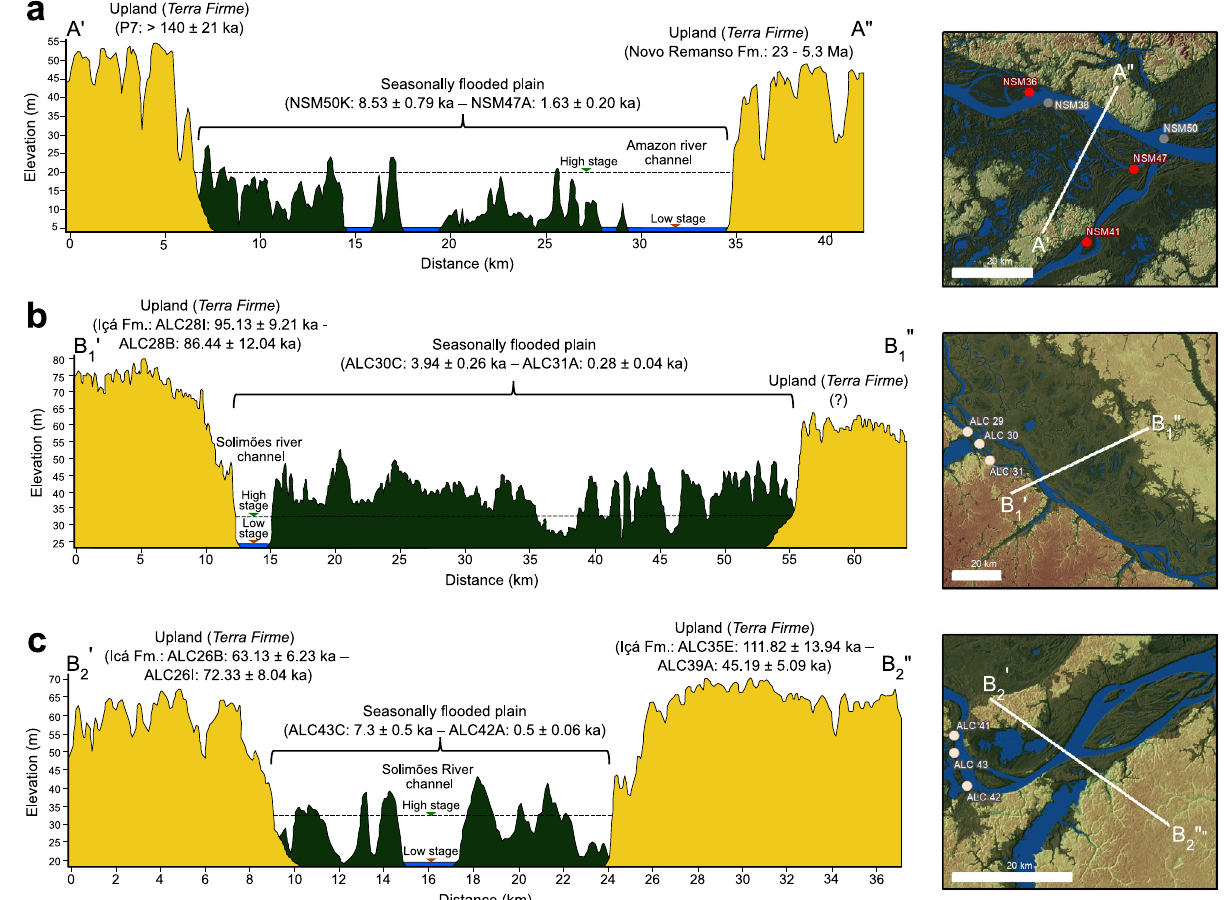
Fig. 6 | Elevation pro fi les showing the morphostratigraphic relation between upland fl uvial terraces and seasonally fl ooded plains within the Solimões- Amazon River valley. a Amazon River main stem near the Madeira River mouth (see location in Fig. 2a, d). Fluvial deposits forming upland terraces correspond to the Novo Remanso Formation (Fm.) and undifferentiated Pleistocene sediments 63